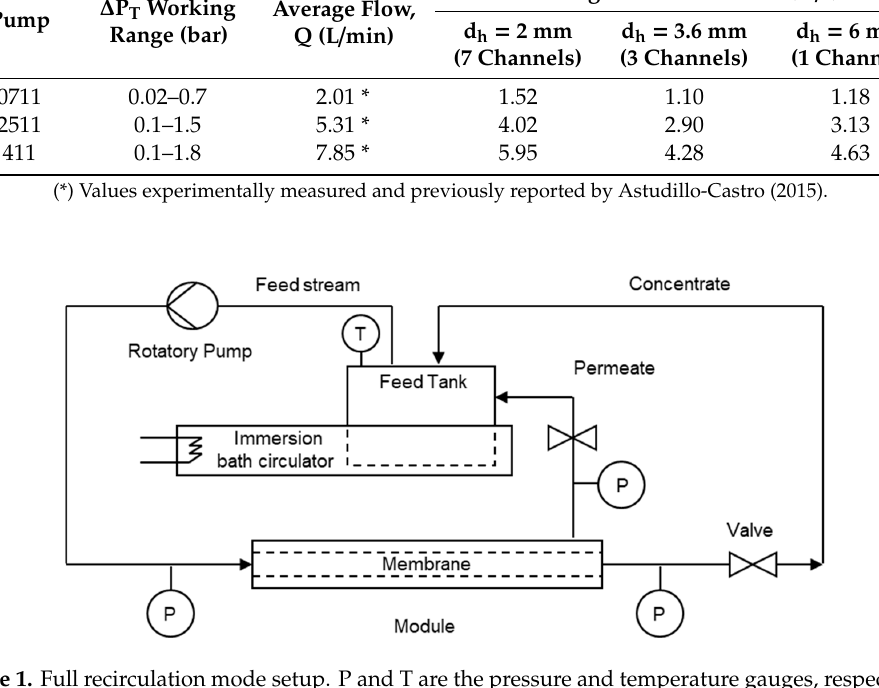
Figure 1. Full recirculation mode setup. P and T are the pressure and temperature gauges,